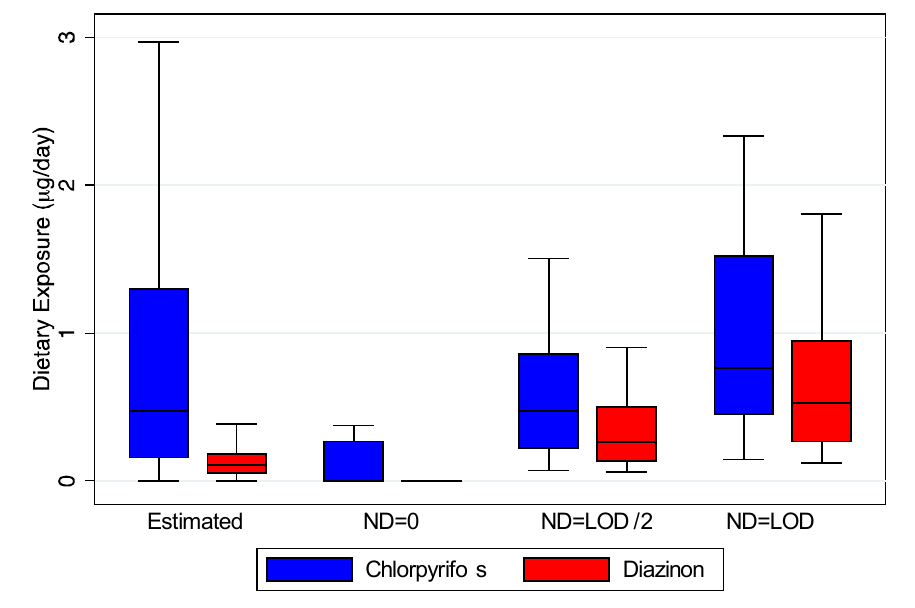
Figure 2. Comparison between dietary exposure estimates and duplicate diet measurements [3], with non-detected values (ND) equal to zero, half the limit of detection (LOD), or LOD.